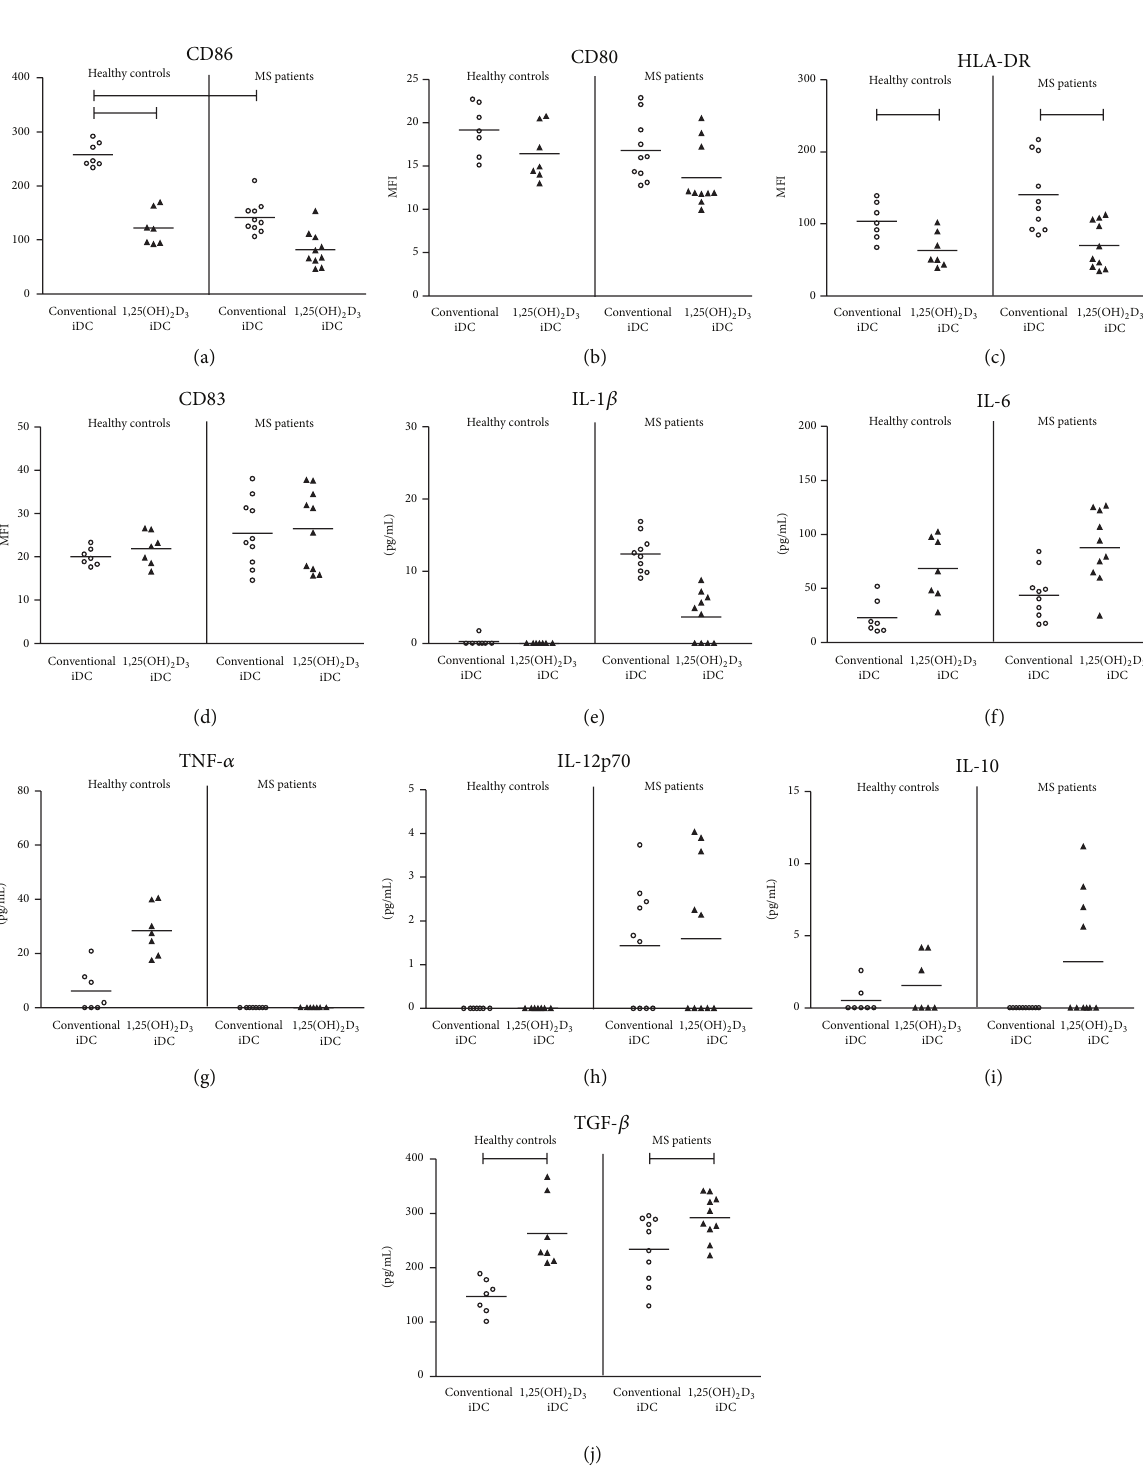
Figure 2: Characterization of in vitro differentiated iDC from healthy controls and MS patients. CD14+ monocytes were cultured for 7 days in the presence of IL-4 and GM-CSF or in the presence of IL-4, GM-CSF, and 1,25(OH) 2 D 3 to obtain conventional iDC (open dots) or 1,25(OH) 2 D 3 -treated iDC (filled triangles), respectively. The expression of (a) CD86, (b) CD80, (c) HLA-DR, and (d) CD83 by DC of healthy controls ( 𝑛 = 7 ) and MS patients ( 𝑛 = 10 ) is determined by flow cytometry. Cytokine secretion of (e) IL-1 𝛽 , (f) IL-6, (g) TNF- 𝛼 , (h) IL-12p70, (i) IL-10, and (j) TGF- 𝛽 by conventional iDC and 1,25(OH) 2 D 3 -treated iDC is determined by a multiplex immunoassay or ELISA. Horizontal lines show the mean. MFI, mean fluorescence intensity, and iDC, immature